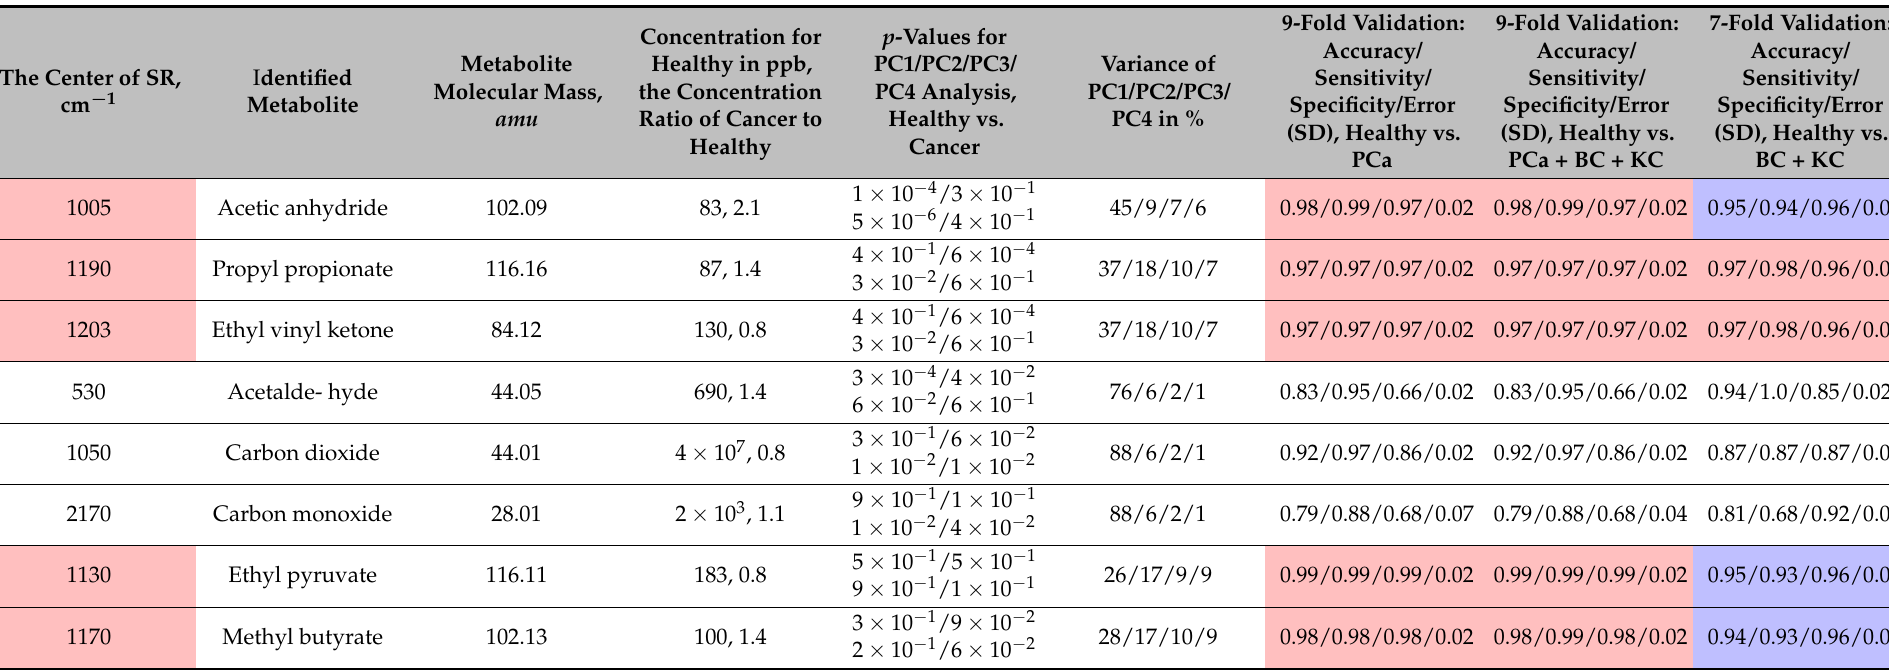
Table 1. Identified spectral regions (SR), corresponding molecules, and results from different statistical analysis methods for healthy and three urogenital cancers.